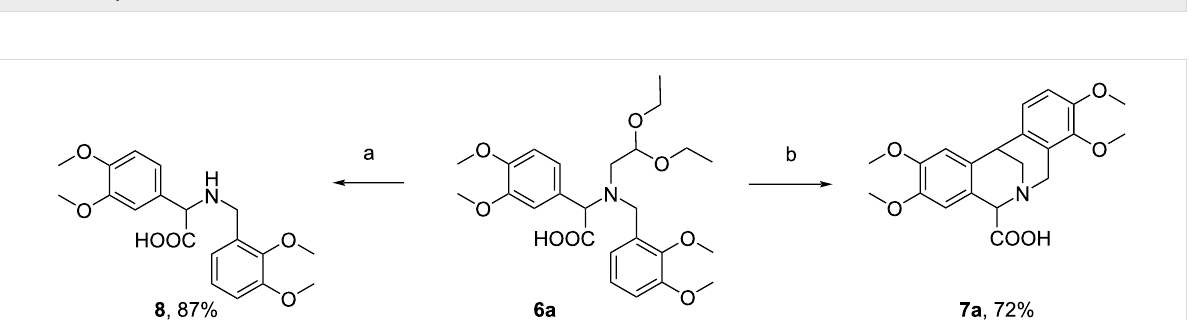
Scheme 6: Synthesis of TA-073.